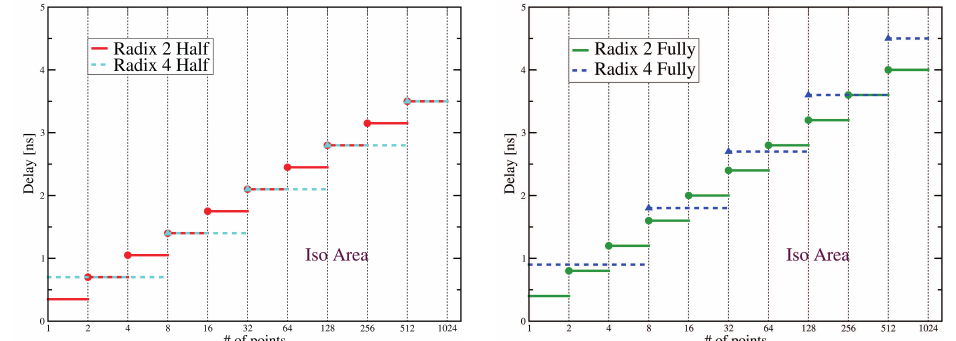
Figure 12. Max-speed implementations: delay vs. topological distance between two I/Os for a 1024 × 1024 fully-bypassed and half-bypassed MSSN.